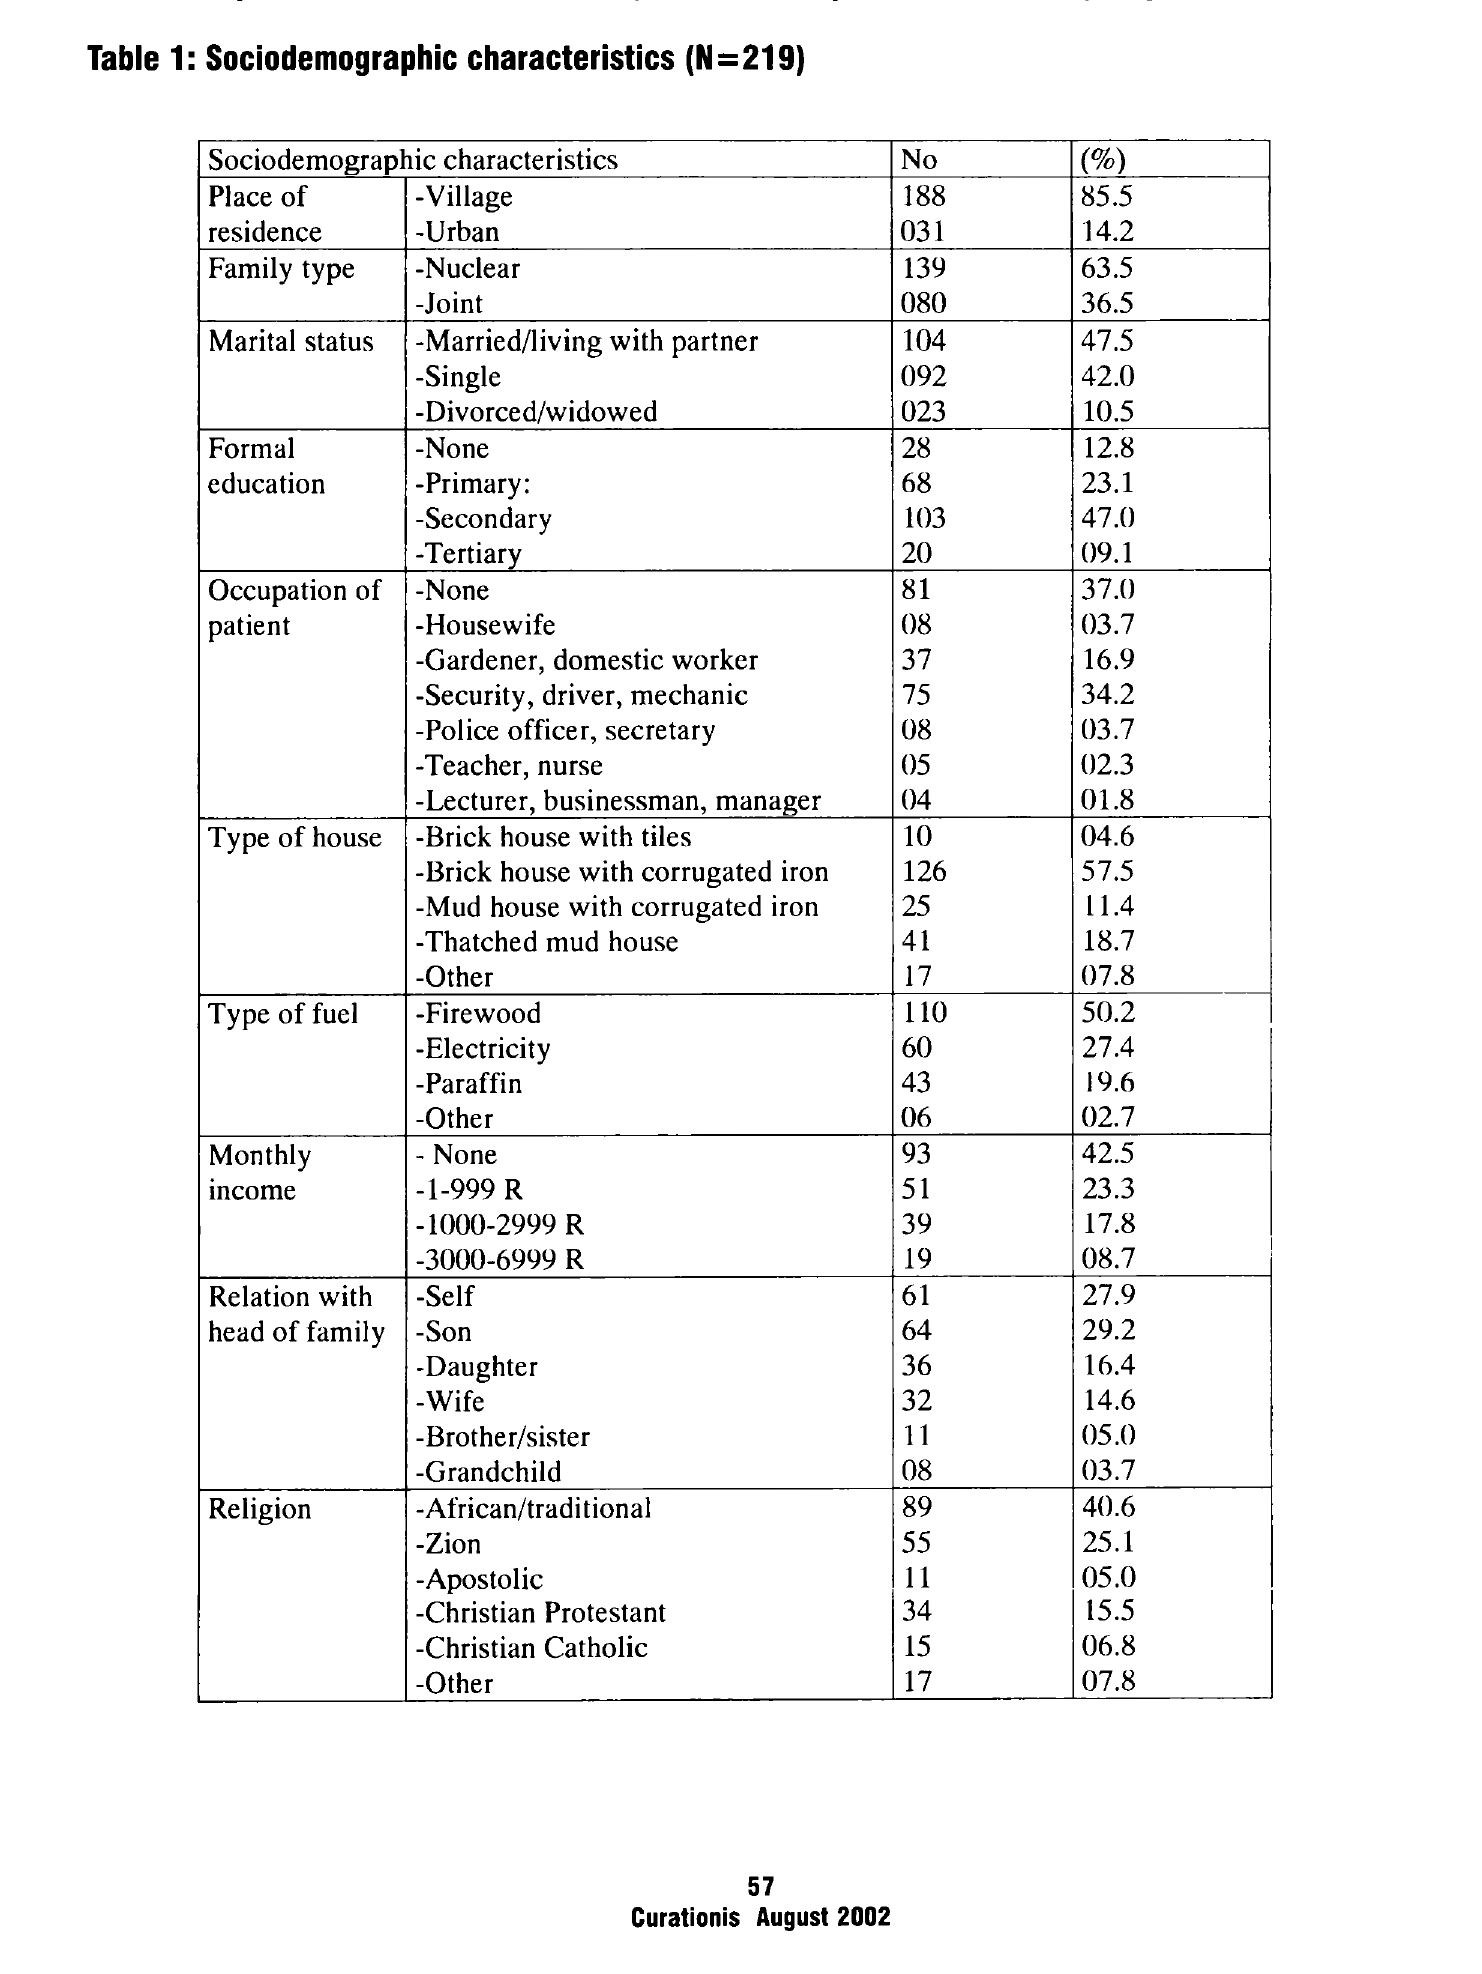
Table 1 : Sociodemographic characteristics (N = 2 19 )